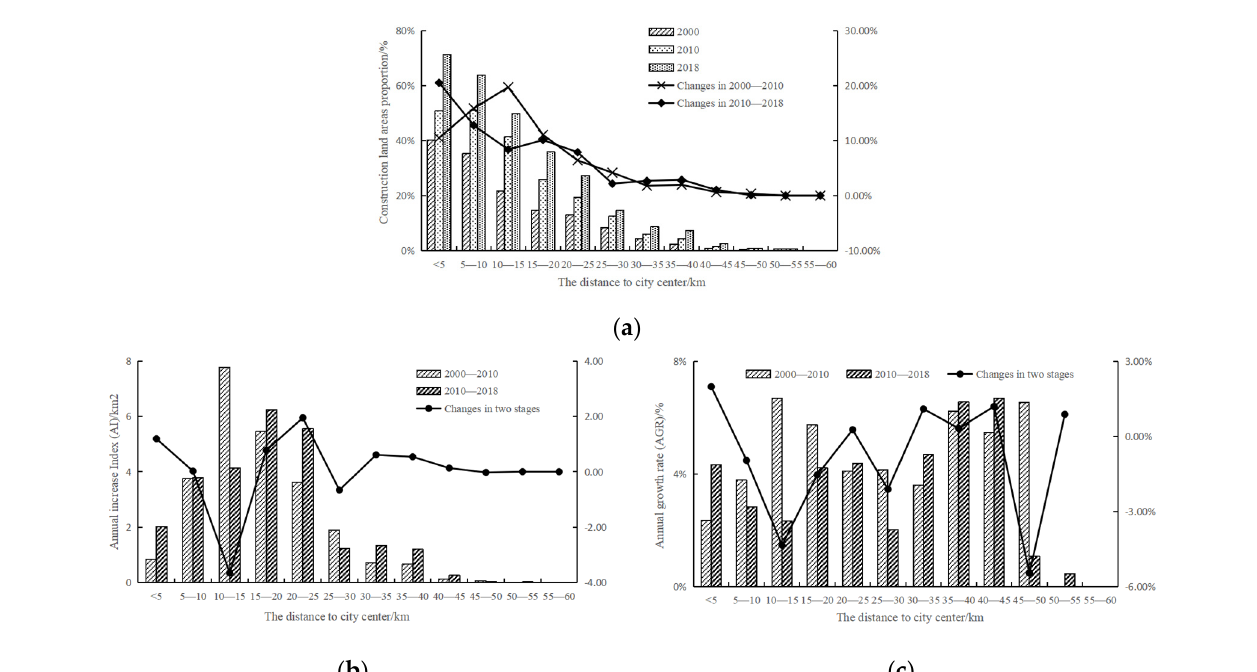
Figure 6. Characteristics of urban expansion from the city center in 2000–2018: ( a ) construction land area proportion; ( b ) annual increase index (AI); ( c ) annual growth rate (AGR).